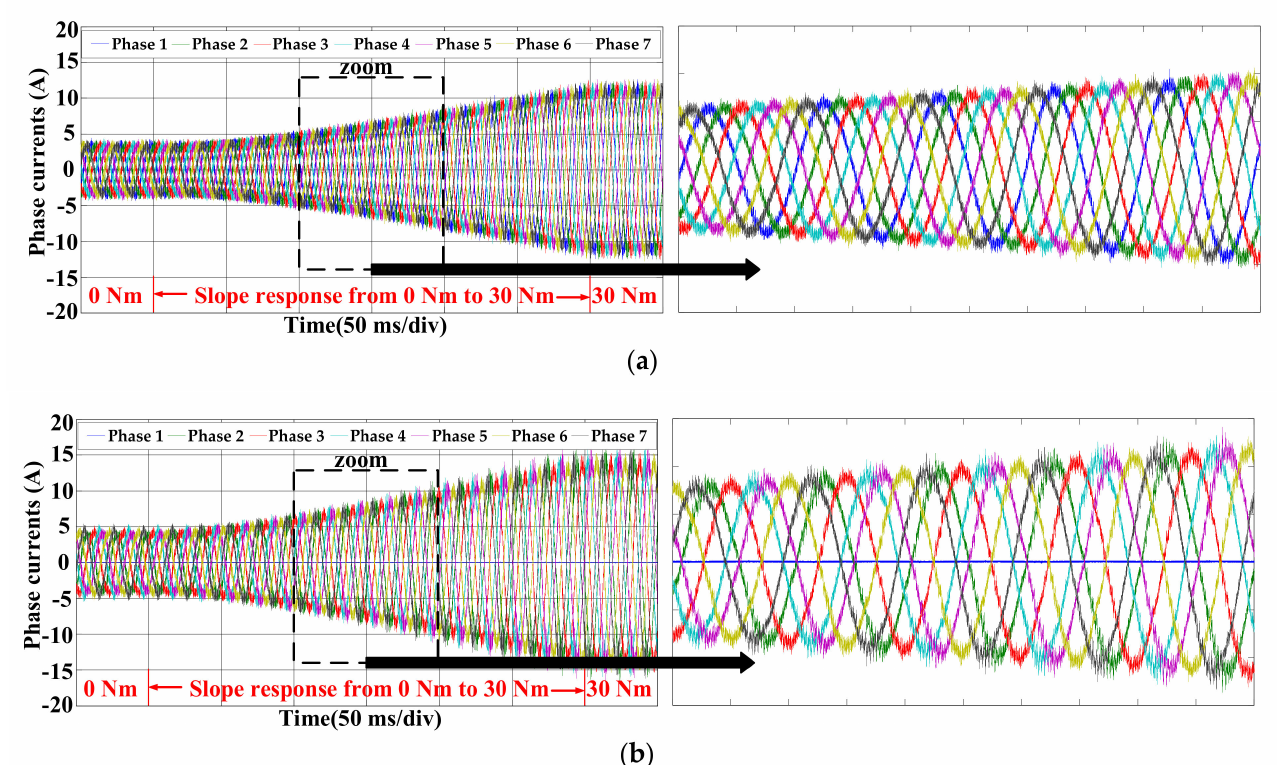
Figure 5. Current performance for the torque slope response. ( a ) Health condition; ( b ) 1 phase fault